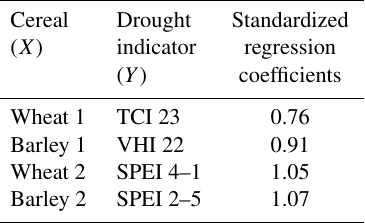
Table 2. Variables used for copula application. In the first column, the numbers 1 and 2 correspond to the respective provincial cluster (clusters 1 and 2). In the second column, the numbers correspond to the selected weeks in the case of the remote sensing indices and to the selected months and timescales (in months) in the case of SPEI. The values of the standardized regression coefficients were determined by Ribeiro et al.